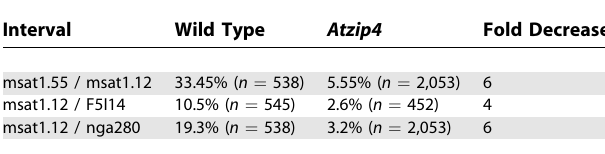
Table 2. Recombination Rate in Male Meiosis Interval Wild